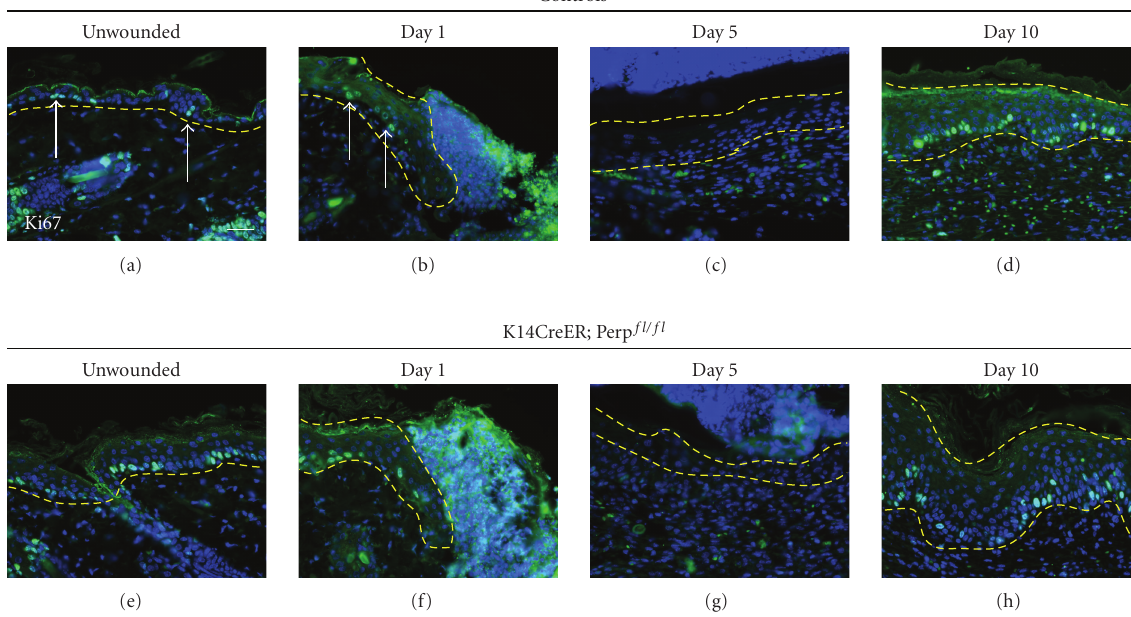
Figure 5: Migrating keratinocytes lacking Perp do not exhibit altered proliferation in vivo . (a)–(d) Representative images of Ki67 staining on sections of wounds at various timepoints post injury in control ( Perp fl/fl ) mice. (e)–(h) Representative images of Ki67 staining of wounds from K14CreER; Perp fl/fl mice. Dashed yellow line surrounds epithelium. DAPI is used to stain nuclei. Arrows indicate Ki67 positive cells. Scale bar equals 50 μm